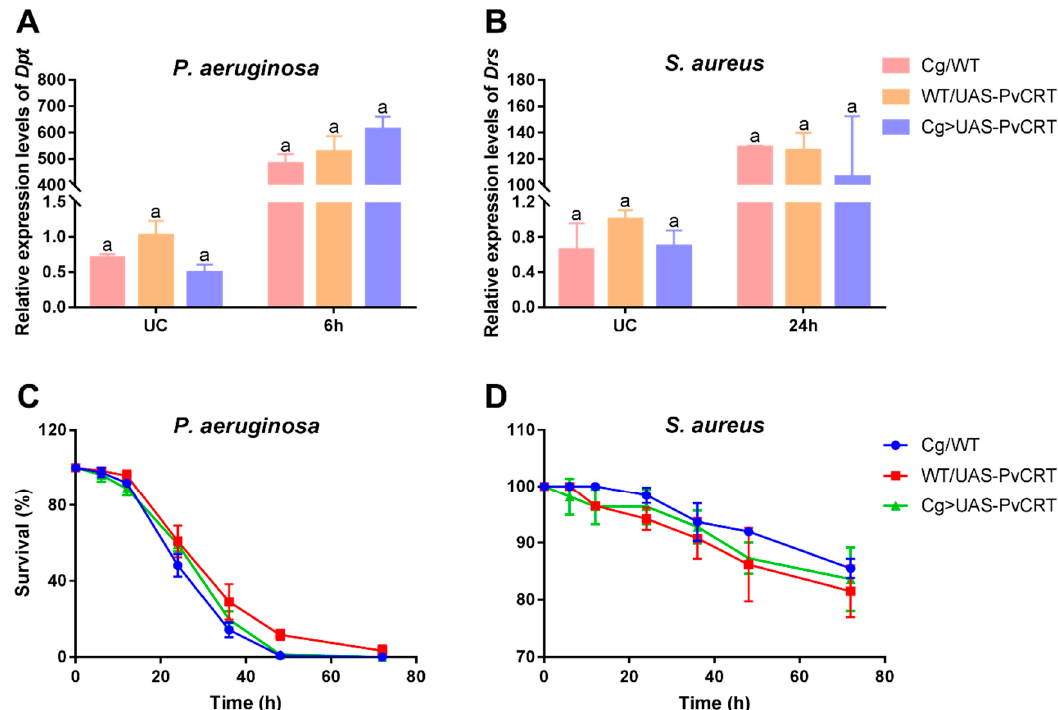
Figure 8. ( A , B ) Expression levels of antimicrobial peptides diptericin ( Dpt ) and drosomycin ( Drs ) in Drosophila adults after infection with P. aeruginosa and S. aureus ( n = 5). UC: unchallenged. ( C , D ) Drosophila adults were infected with bacteria and monitored for survival ( n ≥ 18). One-way ANOVA between different groups were performed followed by Tukey’s multiple comparison tests, and the same letters mean no significant difference.